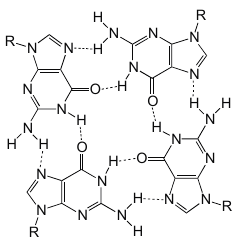
Figure 2. Chemical structure of a GQ (G-quadruplex) tetrad.